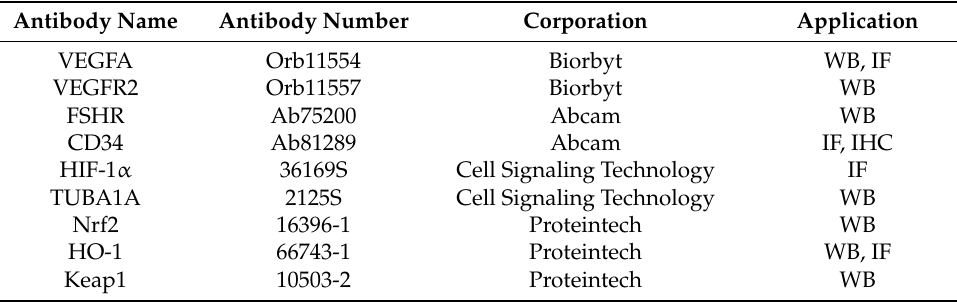
Table 1. The information of antibodies used in this